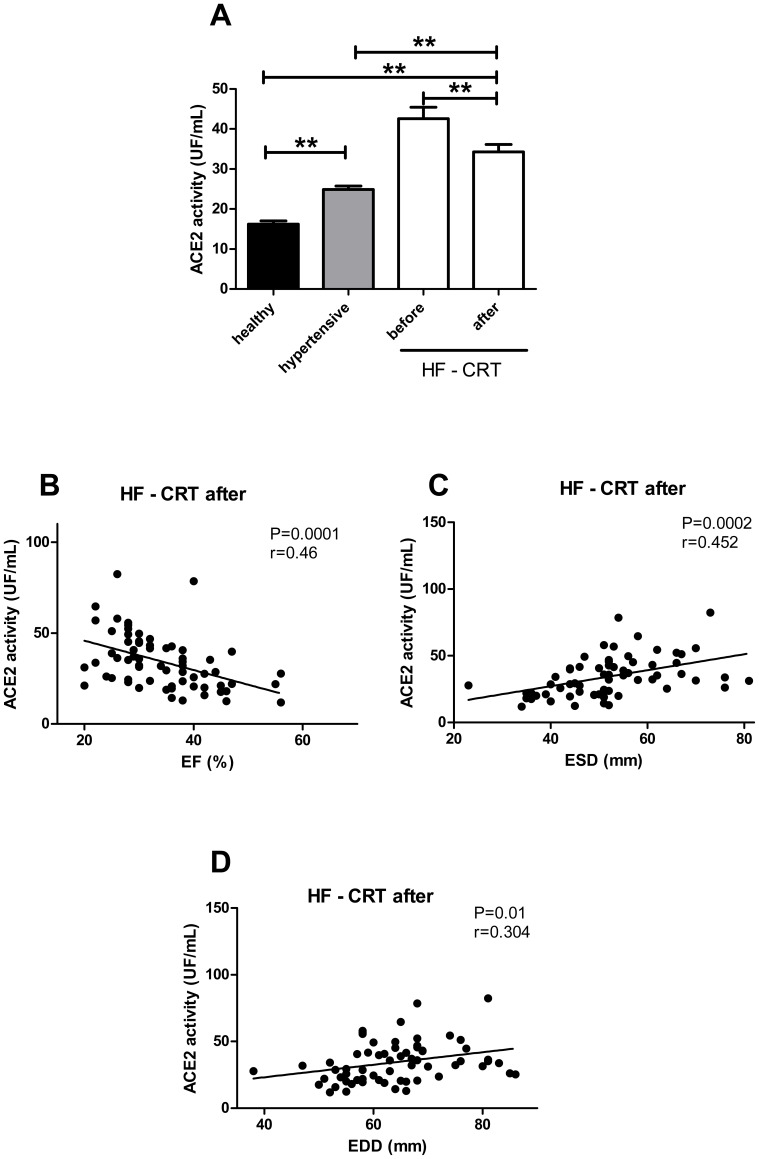
Serum ACE2 activity correlates with reverse remodeling.Serum ACE2 activity was determined in healthy people (healthy, n = 45, filled bar), patients with preserved ejection fraction (hypertensive, n = 239, grey bar) and in patients with severe heart failure before (HF – CRT before) and after (HF – CRT after) cardiac resynchronization therapy (CRT, n = 65, open bars, panel A). Statistical analyses were performed by one-way analysis of variance (ANOVA) followed by Newman-Keuls test for multiple comparisons between groups. Bars represent mean ± S.E.M. Significant differences between values are labeled by asterisks (** P<0.001). In addition, individual values for the patients after CRT (HF – CRT after) are also shown (panels B–D). Serum ACE2 activities were plotted as a function of ejection fraction (EF, panel B), end systolic diameter (ESD, panel C) and end diastolic diameter (EDD, panel D). Plots were fitted by linear regression and the goodness of fits is indicated by the ‘r’ values, while the correlations are represented by the ‘P’ values.